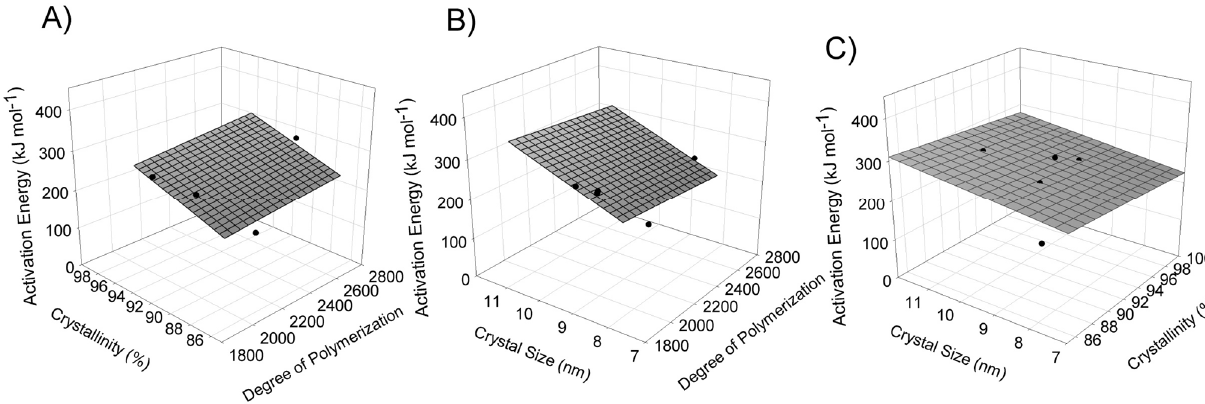
Figure 3. Linear relations found among activation energy, crystallinity, and degree of polymerization ( A ); activation en- ergy, crystal size, and degree of polymerization ( B ); and activation energy, crystallinity, and crystal size ( C ).